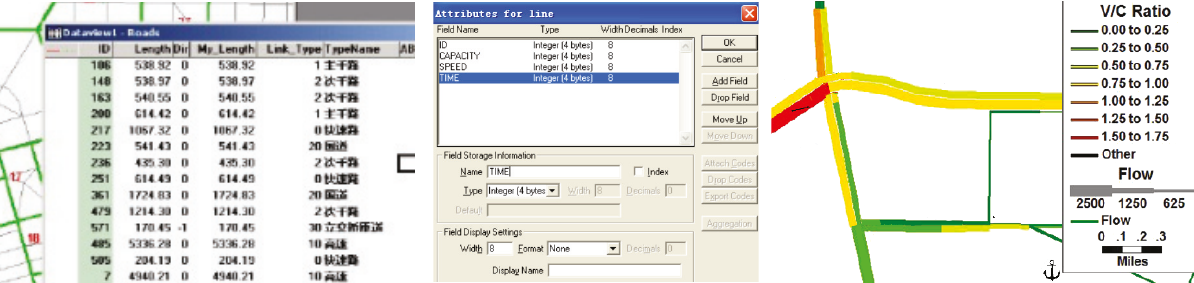
Figure 13: Traffic volume obtained from TransCAD model.